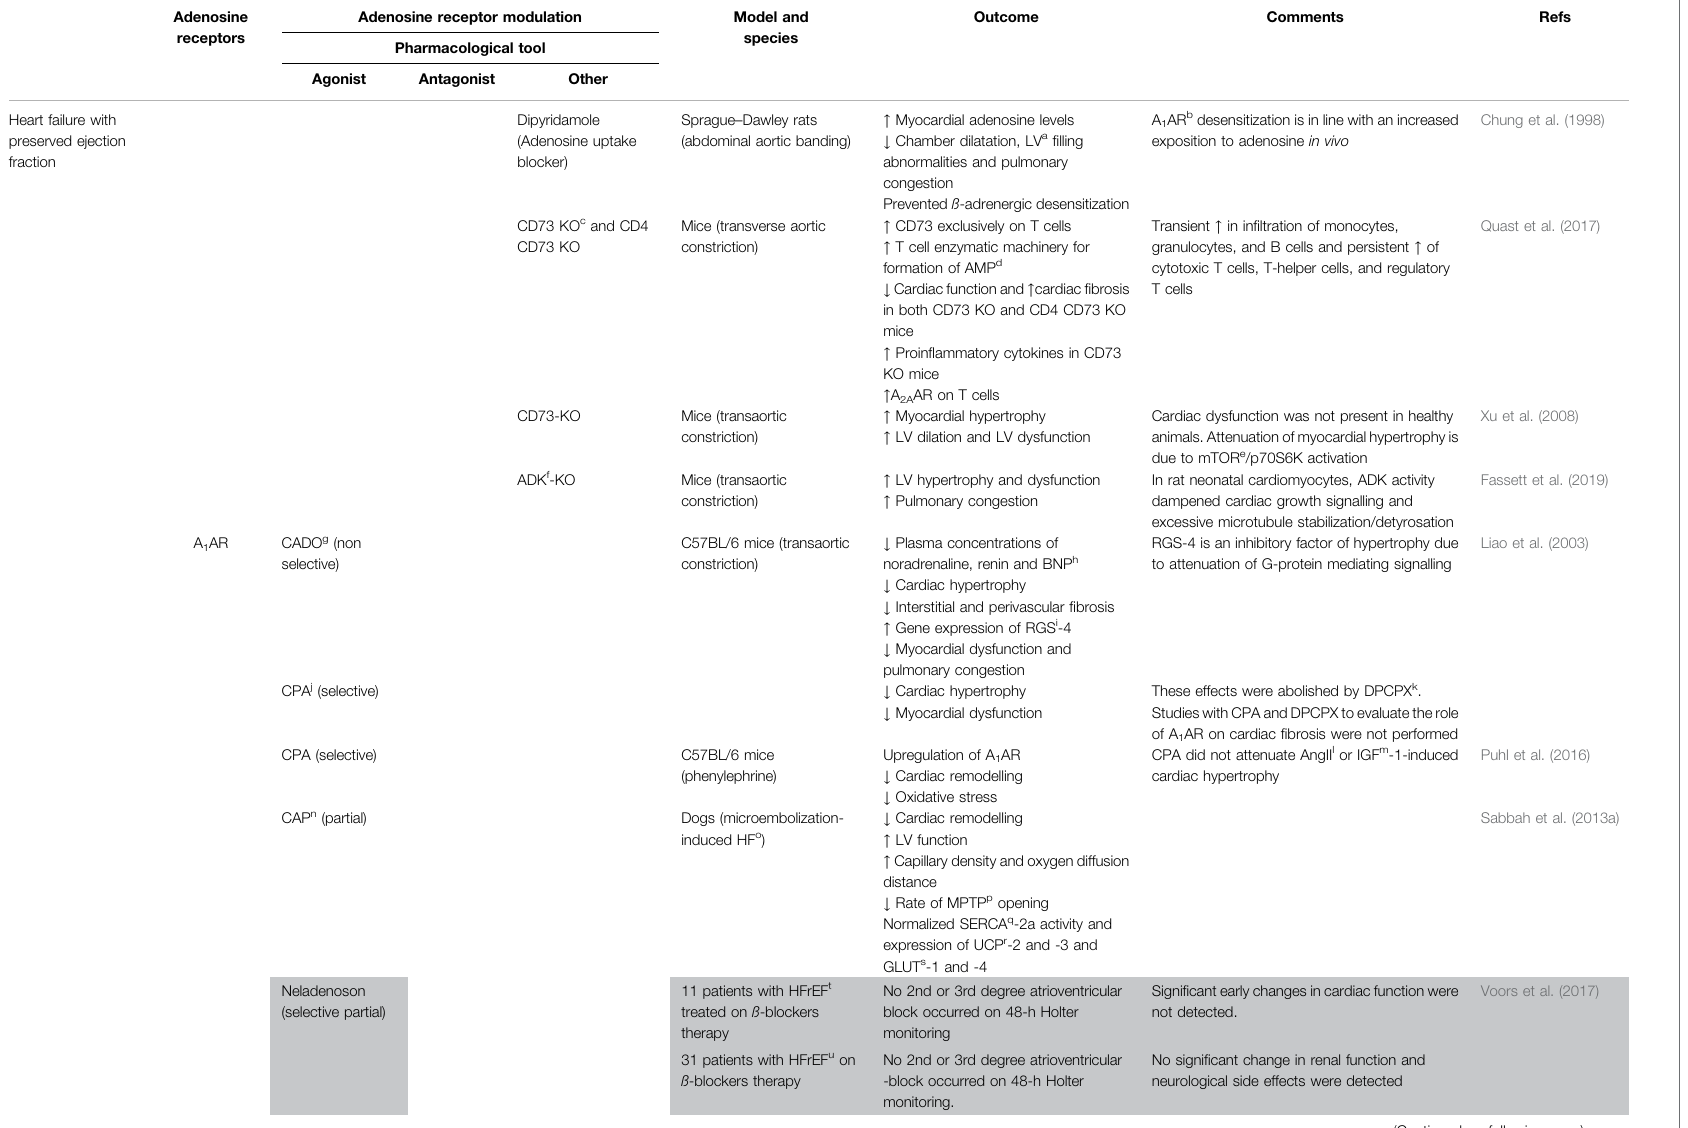
TABLE 1 | Results of adenosine receptors agonism/antagonism in heart failure with preserved ejection fraction and pulmonary hypertension. Different agonists and antagonists were used to assess adenosine effects on cardiovascular diseases. The grey area corresponds to studies carried out in human